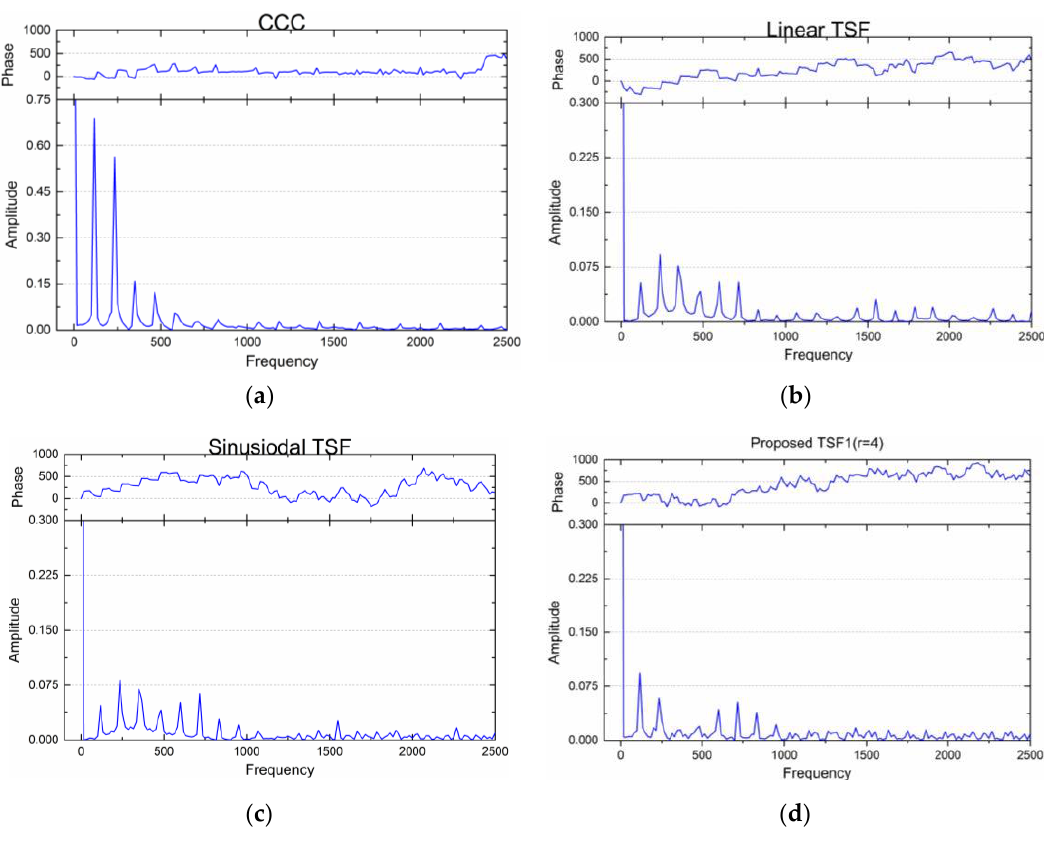
Figure 17. Harmonic component and phase of the total torque ( T ref = 1.5 Nm, speed = 3000 rpm): ( a ) CCC; ( b ) Linear TSF; ( c ) Sinusoidal TSF; ( d ) TSF1 ( r = 4).